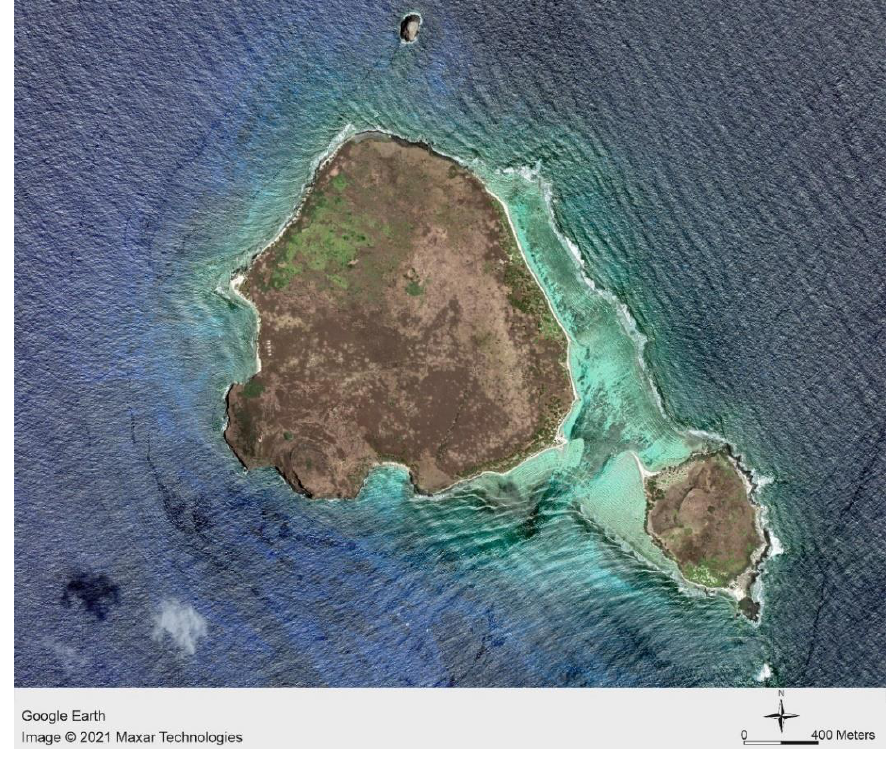
Figure 3. A recent Google Earth image of Flat Island.